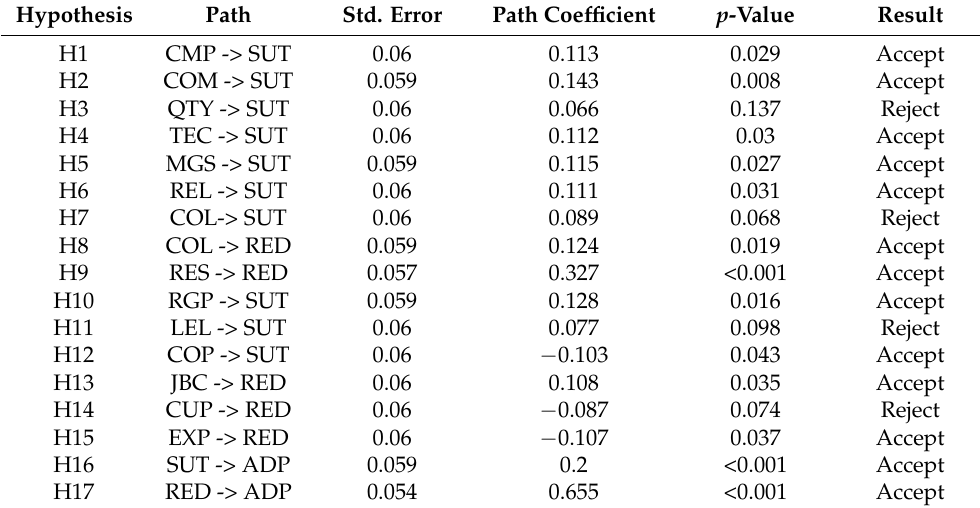
Table 7. Results of path